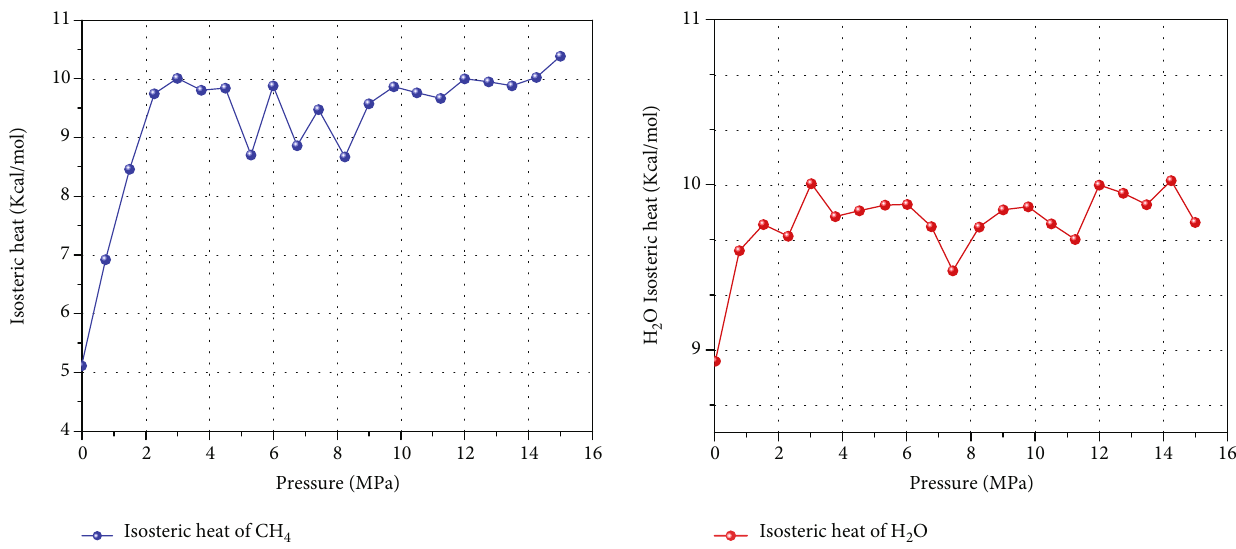
Figure 8: Isothermal adsorption heat curves of two-component at